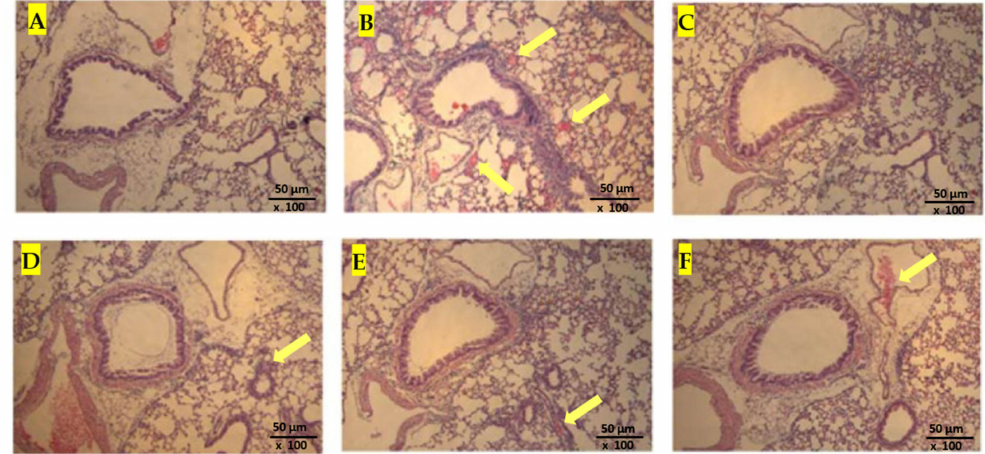
Figure 8. Hematoxylin and eosin-stained lung tissue histopathology images: ( A ) Normal control, ( B ) OVA, disease control, ( C ) DEX, dexamethasone-treated, ( D ) SO, vehicle control sesame oil-treated, ( E ) TUR, turmeric-treated, and ( F ) nano-emulsion-treated group at magnification 100 × ; scale bar = 100 µ